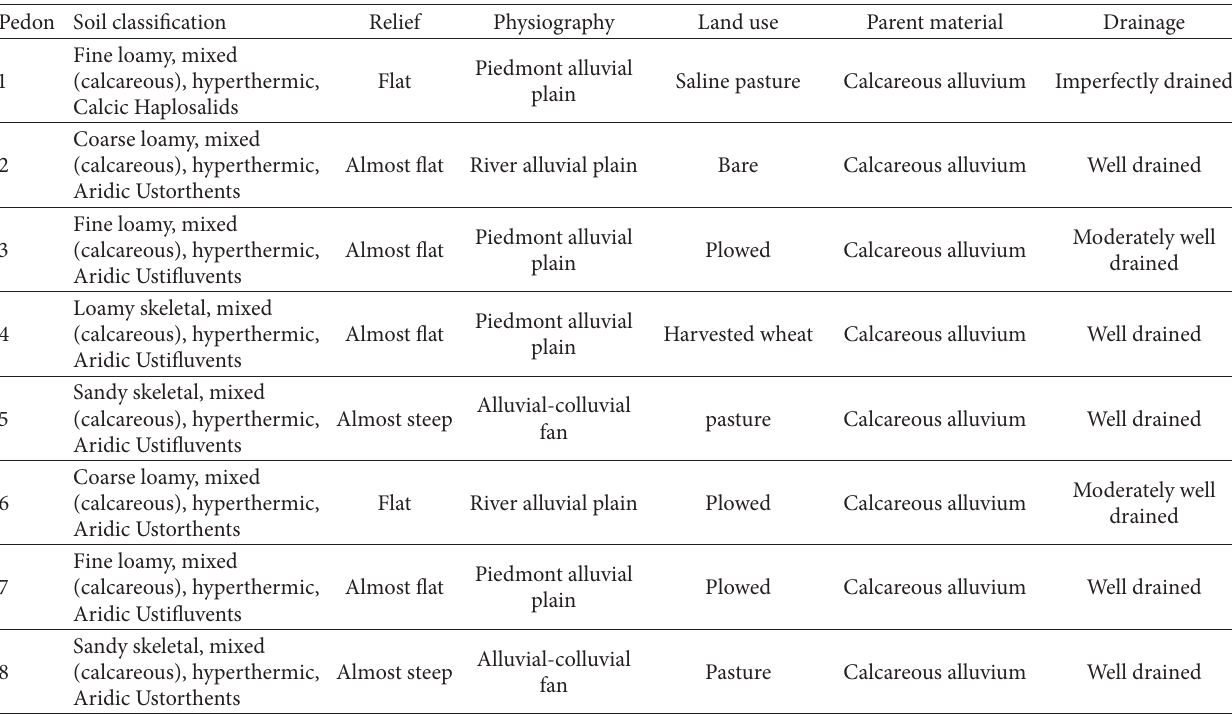
Table 1: General information on the studied